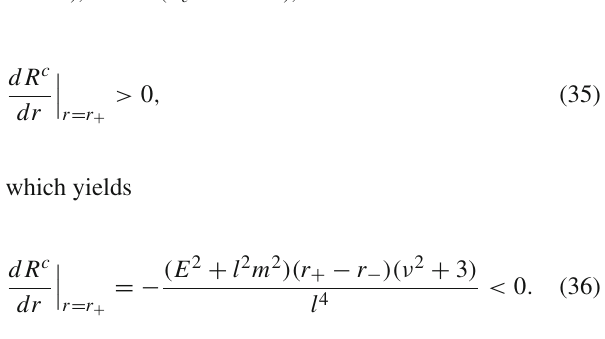
√ 3 ( L c = − 1 . 015 ),ν = 2 . 5 ( L c =